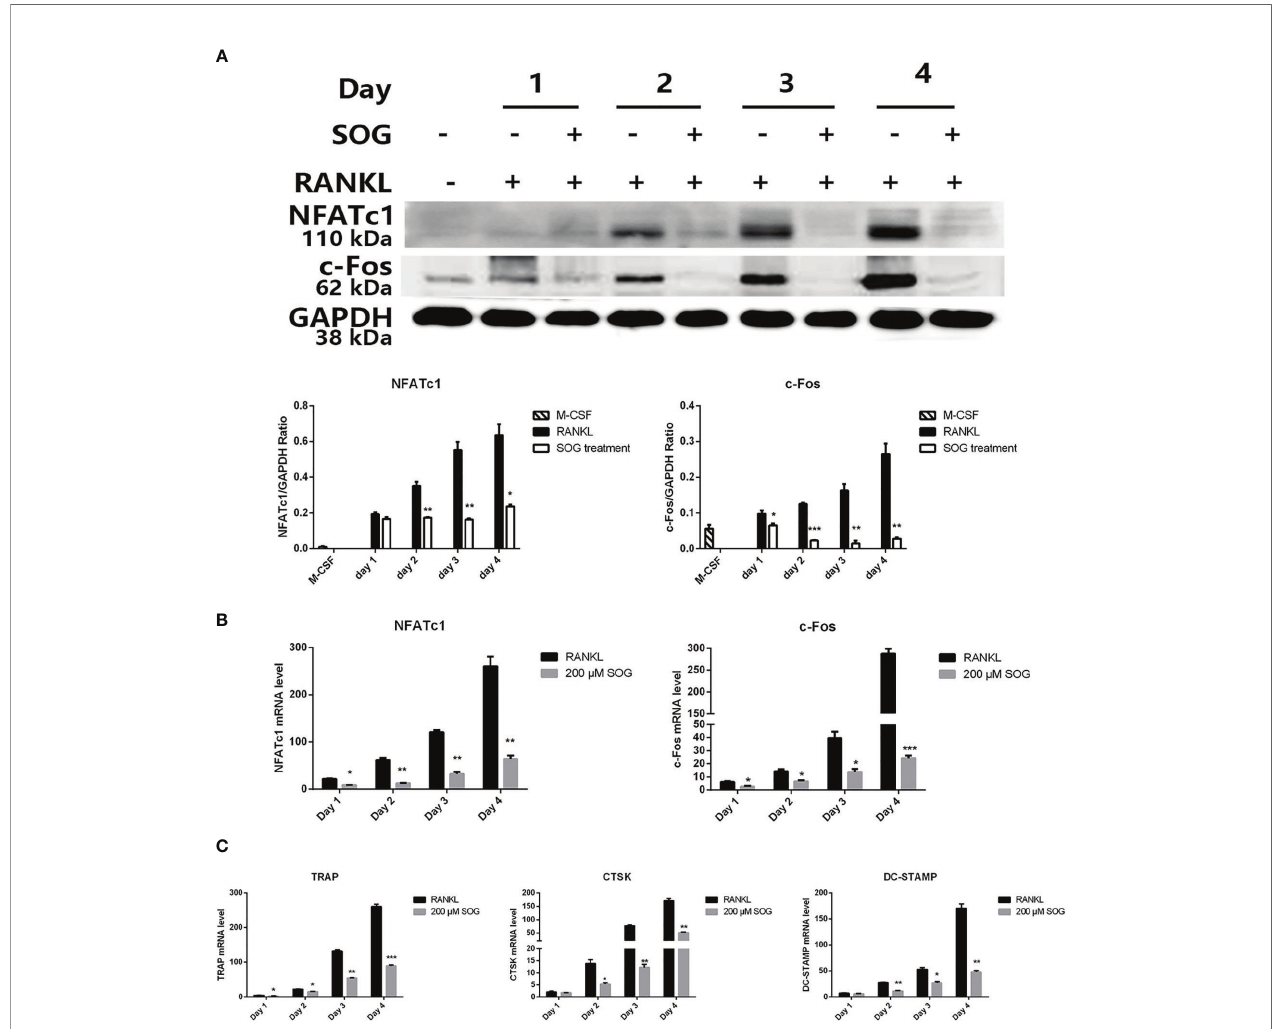
FIGURE 3 | SOG reduced the RANKL-induced expression of c-Fos, NFATc1, and osteoclast-speci fi c genes in BMMs cultured with M-CSF, RANKL, and 200 m M SOG for up to 4 d (A) c-Fos and NFATc1 protein levels as determined by western blotting analysis. Real-time PCR analysis of c-Fos and NFATc1 (B) and TRAP , CTSK , and DC-STAMP (C) expression. All experiments were performed at least three times. * p < 0.05, ** p < 0.01, and *** p < 0.001 versus RANKL-positive